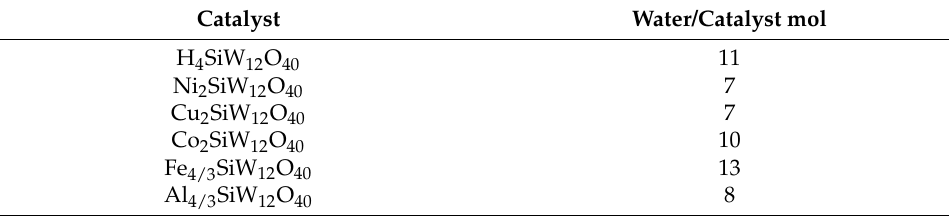
Figure 6. Powder XRD patterns of silicotungstic acid and their metal-exchanged cations (adapted from ref. [27]). Table 1. Hydration water molecules were determined through thermal analysis (DTG)